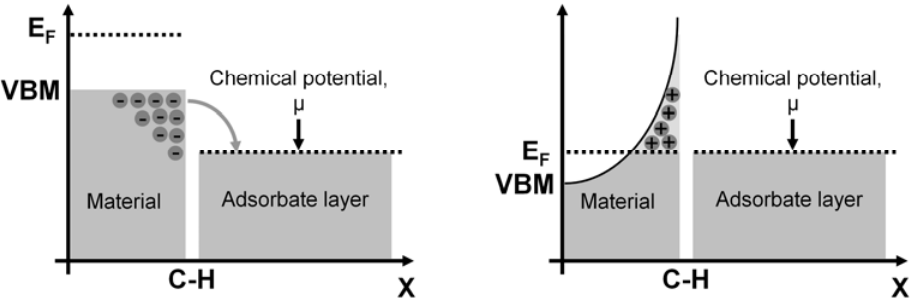
Figure 8. Schematic diagram of the diamond/electrolyte interface. Under non-equilibrated conditions (left panel), electrons from the valence band of the diamond tunnel into empty electronic states of the electrolyte. This continues until the E electrolyte align and reach thermodynamic equilibrium (right panel) [8].